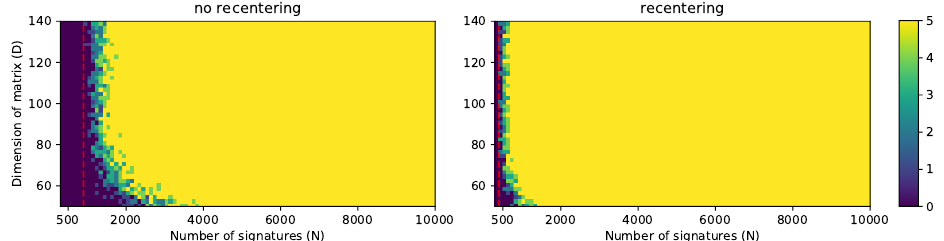
Figure 15: Heatmap of success rate (out of 5 tries) when the true leading zero bits are used as bounds, thus showing the real minimum of the signatures required.